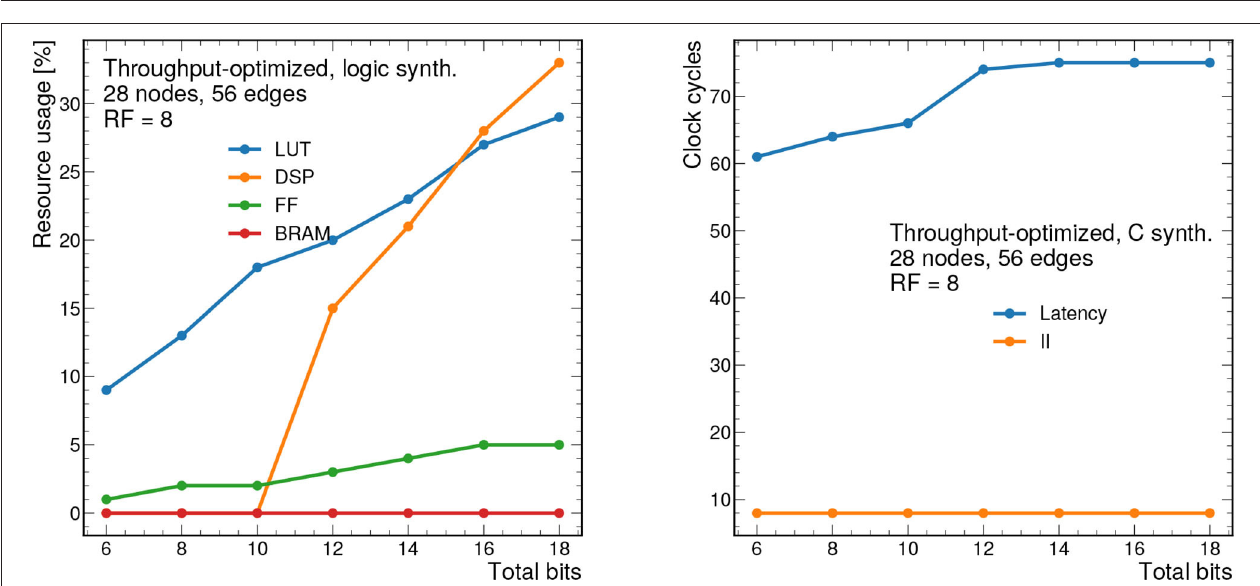
FIGURE 8 | Resource usage estimates as a percentage after logic synthesis (left) and latency and II in clock cycles (right) for a constant reuse factor of 8 as a function of the total bit width.